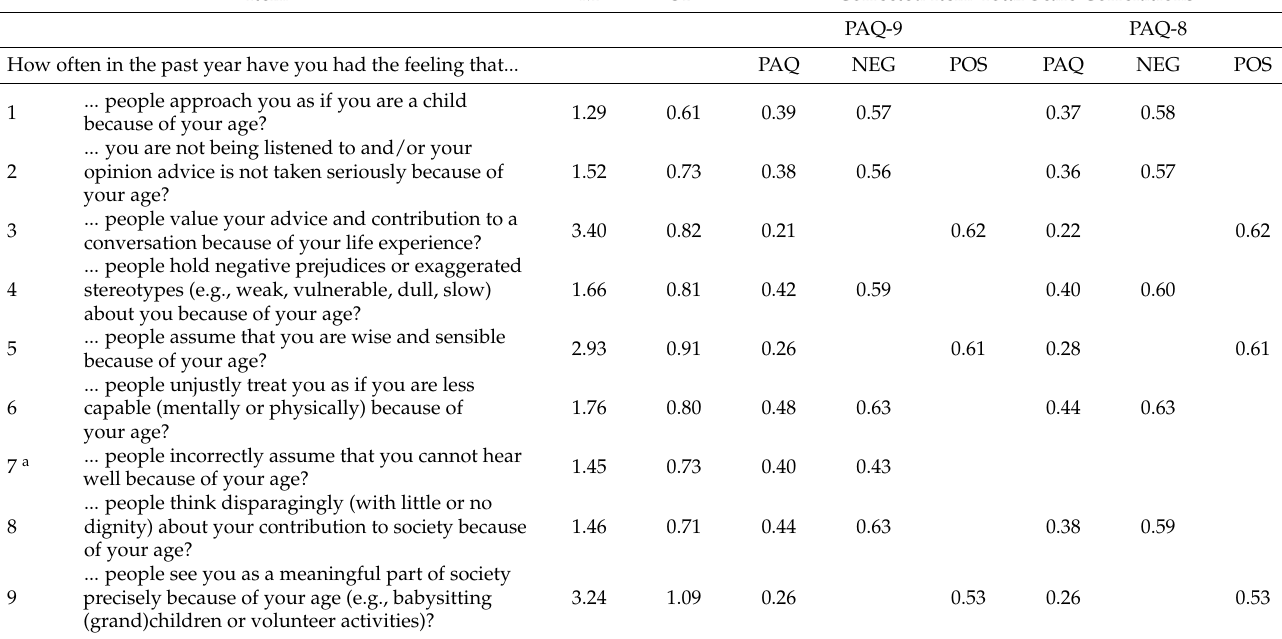
Table 2. Descriptive statistics (means, SD) and corrected item-total scale correlations of Analysis 1 for the PAQ-9 and